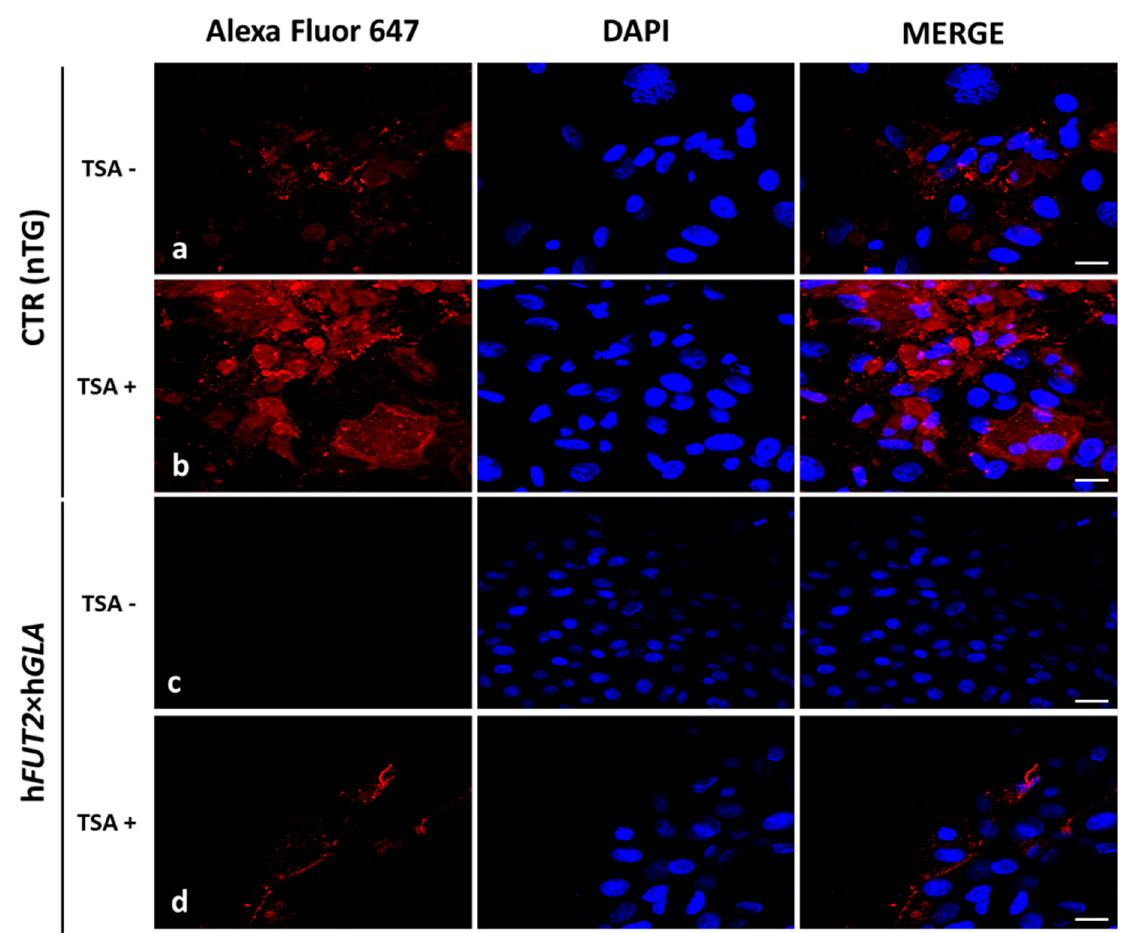
Figure 5. Lectin fluorescence analysis of Gal α 1 → 3Gal epitope expression in the in vitro-cultured porcine transgenic and non-transgenic ACFCs treated (TSA + ) ( b , d ) and not treated with trichostatin A (TSA − ) ( a , c ). Representative microphotographs of lectin GS-IB 4 labelled sections derived from non-transgenic control (CTR nTG; a , b ) and double-transgenic (h FUT2 × h GLA ; c , d ) pigs. The lectin fluorescence analysis was performed with the use of Alexa Fluor 647-conjugated lectin GS-IB 4 (red fluorescence) and 4 ′ ,6-diamidino-2-phenylindole (DAPI)-mediated counterstaining of cell nuclei (blue fluorescence). Scale bars represent 50 μ m.